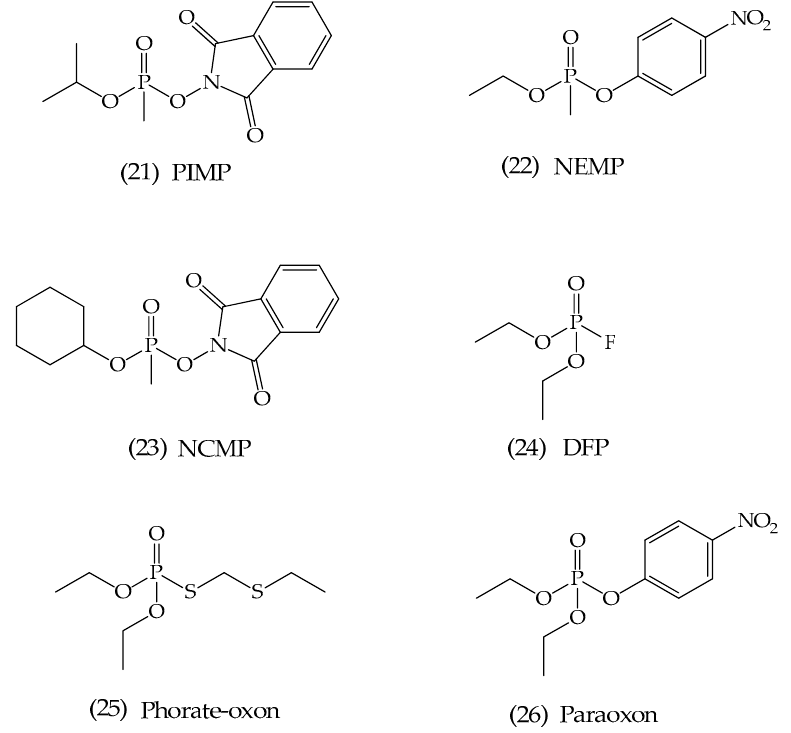
Figure 15. Representation of the chemical structures of some organophosphorus (OP) used in the patent.